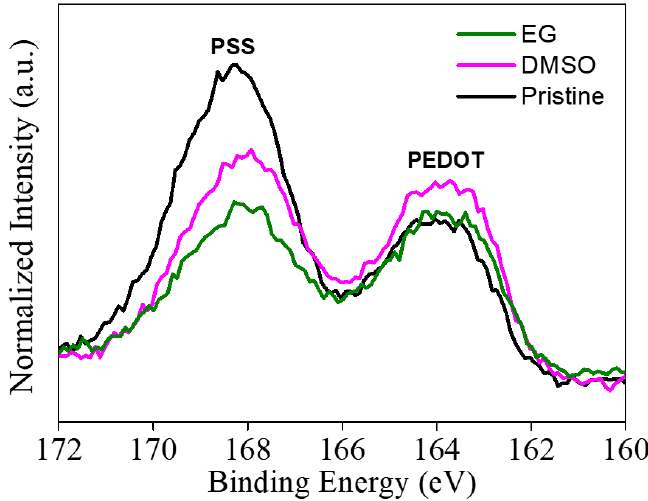
Figure 3. XPS S(2p) spectra of PEDOT:PSS/CNF nanocomposite paper before and after post-treatment with EG and DMSO.